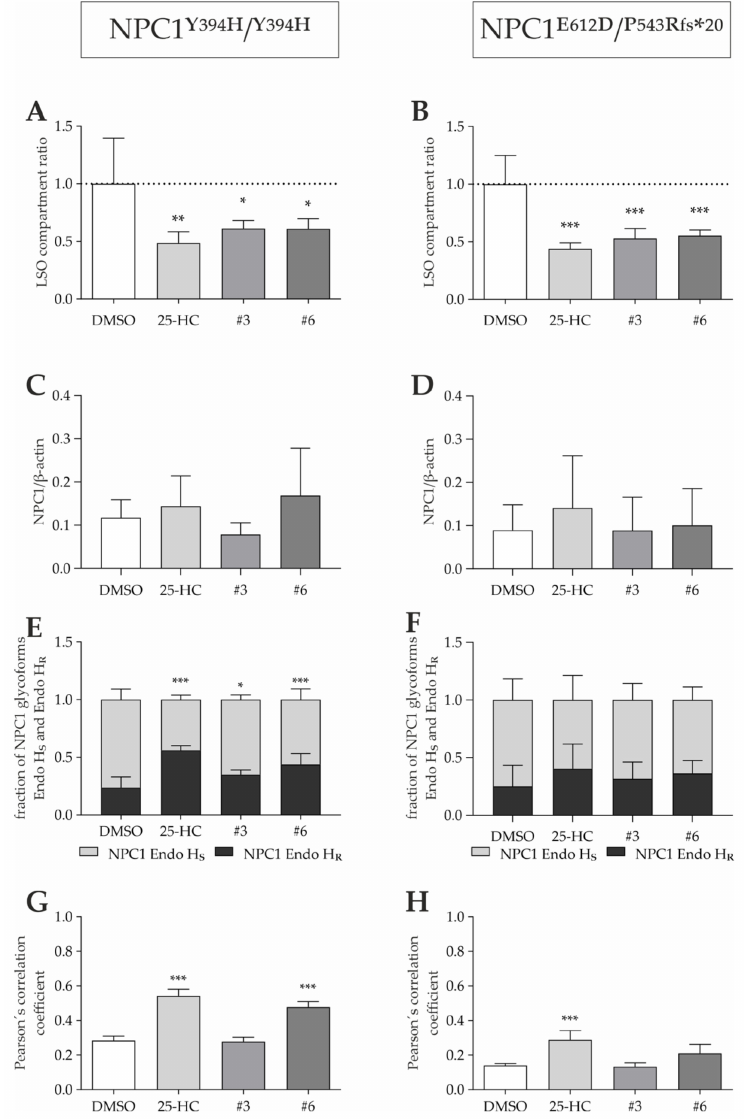
Figure 7. Treatment of NPC1-deficient fibroblasts with potential PCs. ( A , B ) Treatment with 10 µ M 25-HC, quinestrol (#3), or abiraterone acetate (#6) for 48 h leads to a significant decrease in cholesterol accumulation. N = 5. ( C , D ) No change in total NPC1 protein levels was observed by Western blot. N = 4–7. ( E , F ) The Endo H-resistant and Endo H-sensitive glycoforms of NPC1 protein are indicated as a fraction of total NPC1 (Endo H R + Endo H S ). Treatment led to an increase in Endo H-resistant NPC1 protein in NPC1 Y394H/Y394H fibroblasts. N = 4–7. ( G , H ) Increased lysosomal NPC1 protein content was observed upon treatment with 25-HC and abiraterone acetate (#6) in NPC1 Y394H/Y394H fi- broblasts, and upon treatment with 25-HC only in NPC1 E612D/P543Rfs*20 fibroblasts. N = 4. * = p < 0.05, ** = p < 0.01, *** = p < 0.001 by one-way ANOVA, followed by the Dunnett’s post hoc test (in A , B , E – H ) or Kruskal–Wallis test, followed by Dunn’s post hoc test (in C , D ) compared to DMSO vehicle control. Endo H R = Endoglycosidase H-resistant; Endo H S = Endoglycosidase